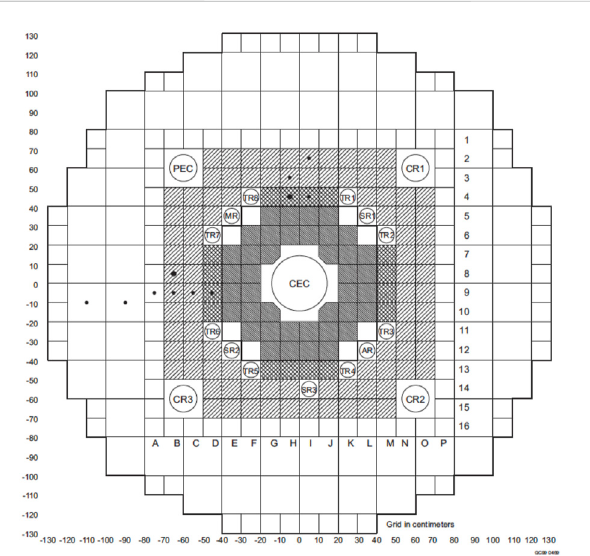
FIGURE 7 Cross-Sectional View of IGR Core and Re fl ector (the three fuel regions are